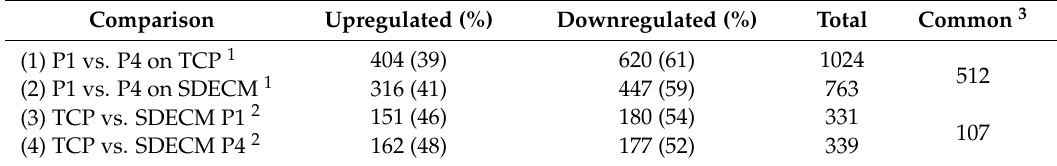
Table 1. Summary of differentially expressed genes (Adjusted p -value < 0.01 and log2 fold-change